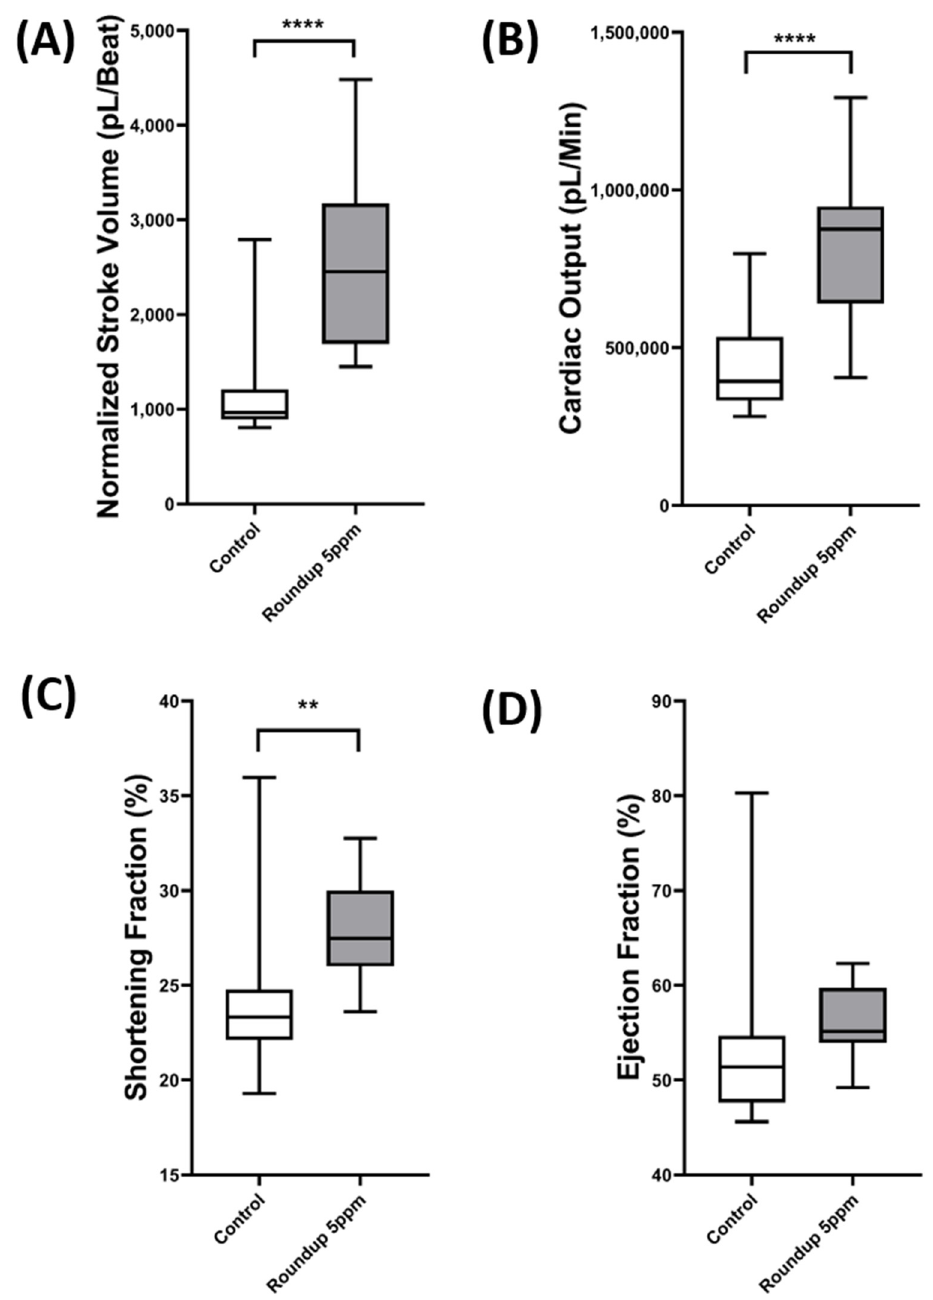
Figure 6. Comparison of cardiac physiology parameters after incubation in 5 ppm of Roundup for 24 h. The heart size was first predicted by Mask RCNN, and later the long and short axes of the cardiac chamber was predicted by OpenCV. Next, we used long and short axis lengths to assess cardiac physiology by measuring stroke volume ( A ), cardiac output ( B ), shortening fraction ( C ), and ejection fraction ( D ). The data were shown as mean ± SD, and the statistical significance was compared using an unpaired student t-test (** p <0.01, **** p <0.0001).